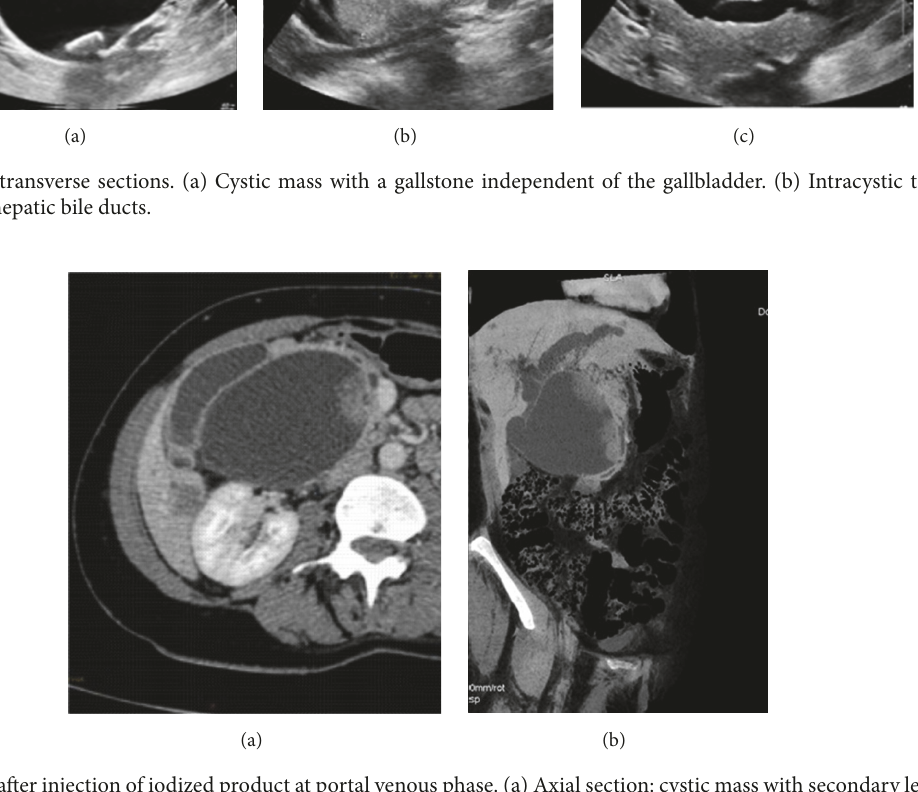
Figure 2: CT sections after injection of iodized product at portal venous phase. (a) Axial section: cystic mass with secondary lesion of the VI segment. (b) Oblique reconstruction showing mass relationship with the bile